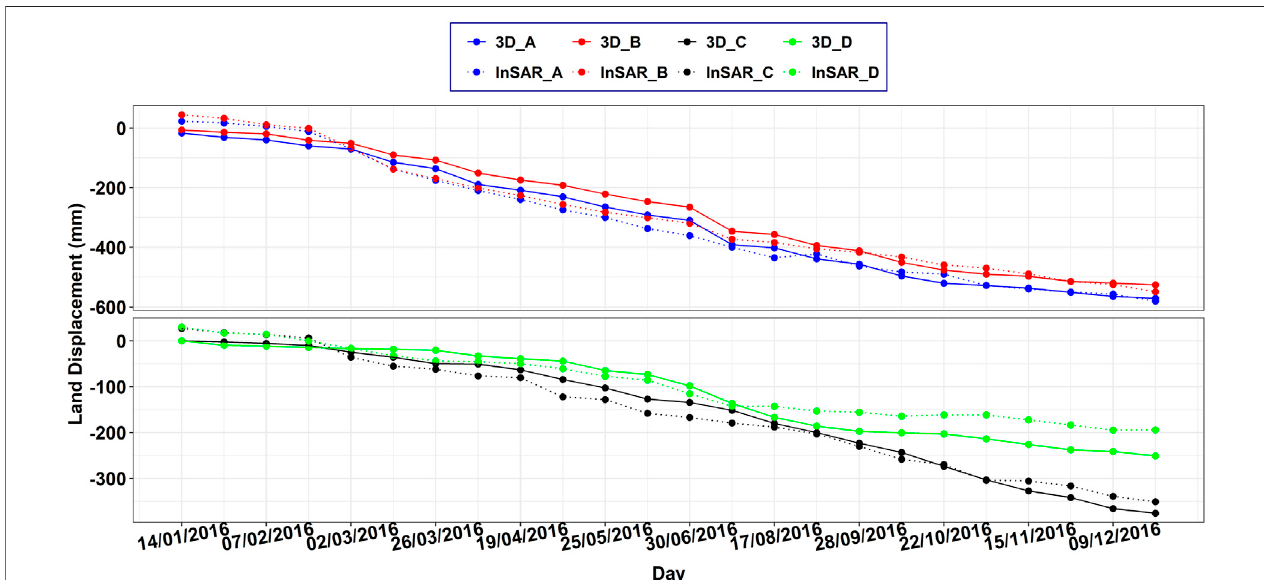
FIGURE 6 | Time series comparison for FDM model and InSAR subsidence and at point A, B, C and D.